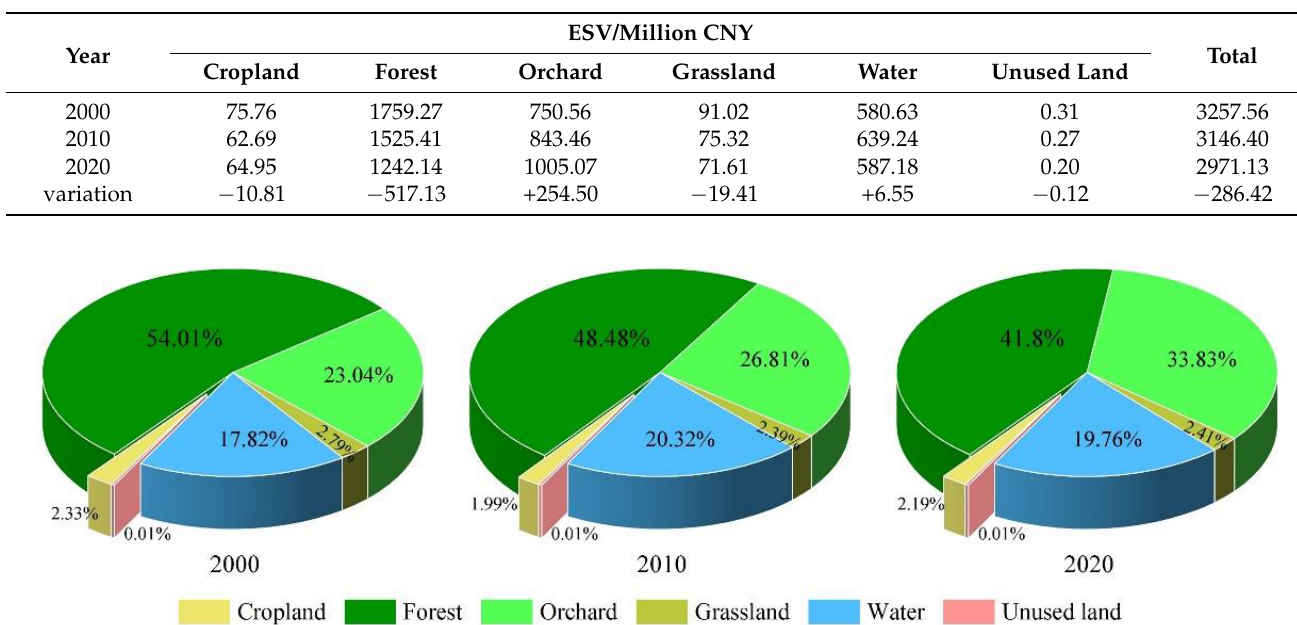
Figure 6. Proportion of ESV in different land use types.